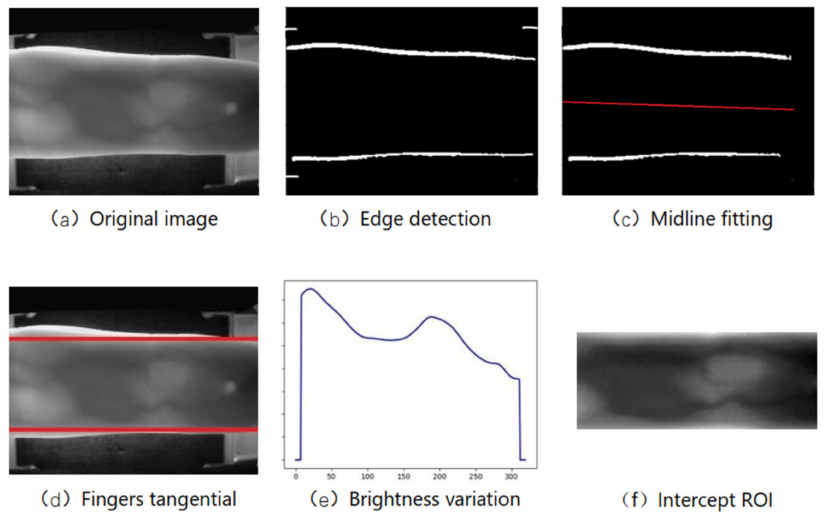
Figure 5. SDUMLA-FV dataset image